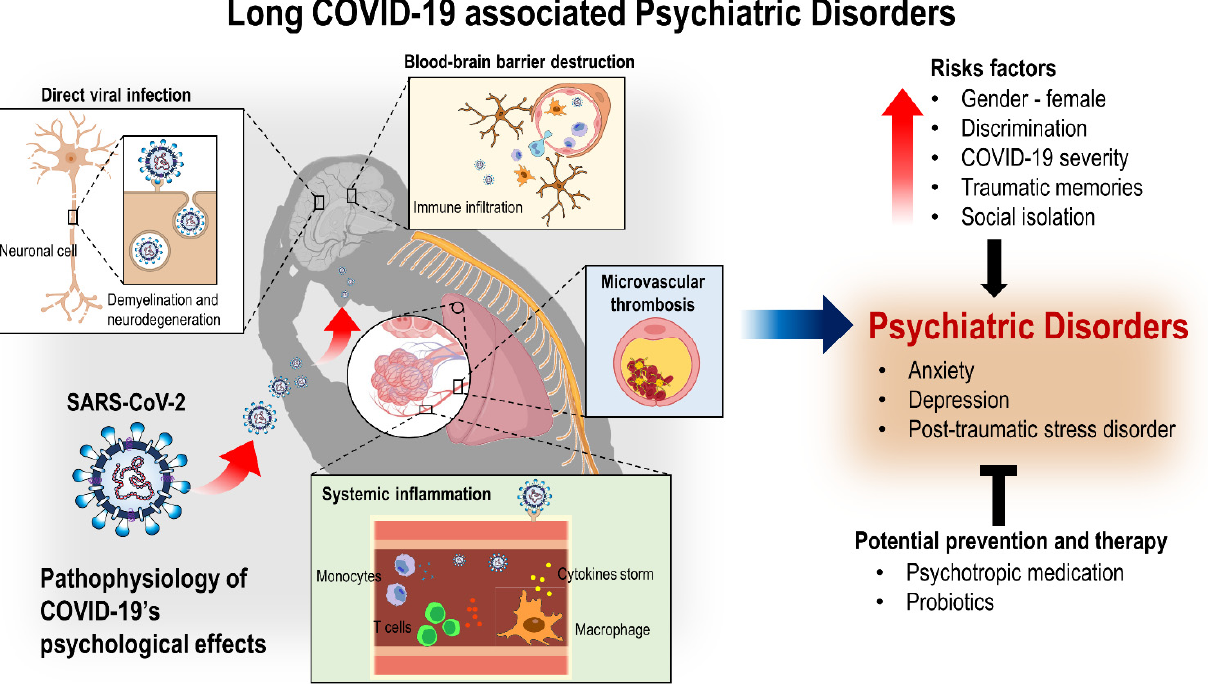
Figure 3. Illustration of long COVID-19-associated psychiatric disorders. It is known that COVID-19 psychologically af- fects patients, leading to psychiatric disorders such as anxiety, depression, and post-traumatic stress disorder. These symp- toms can be potentially alleviated by probiotics, as they may be one of the safest adjunctive treatments for alleviating psychiatric sequelae in post COVID-19